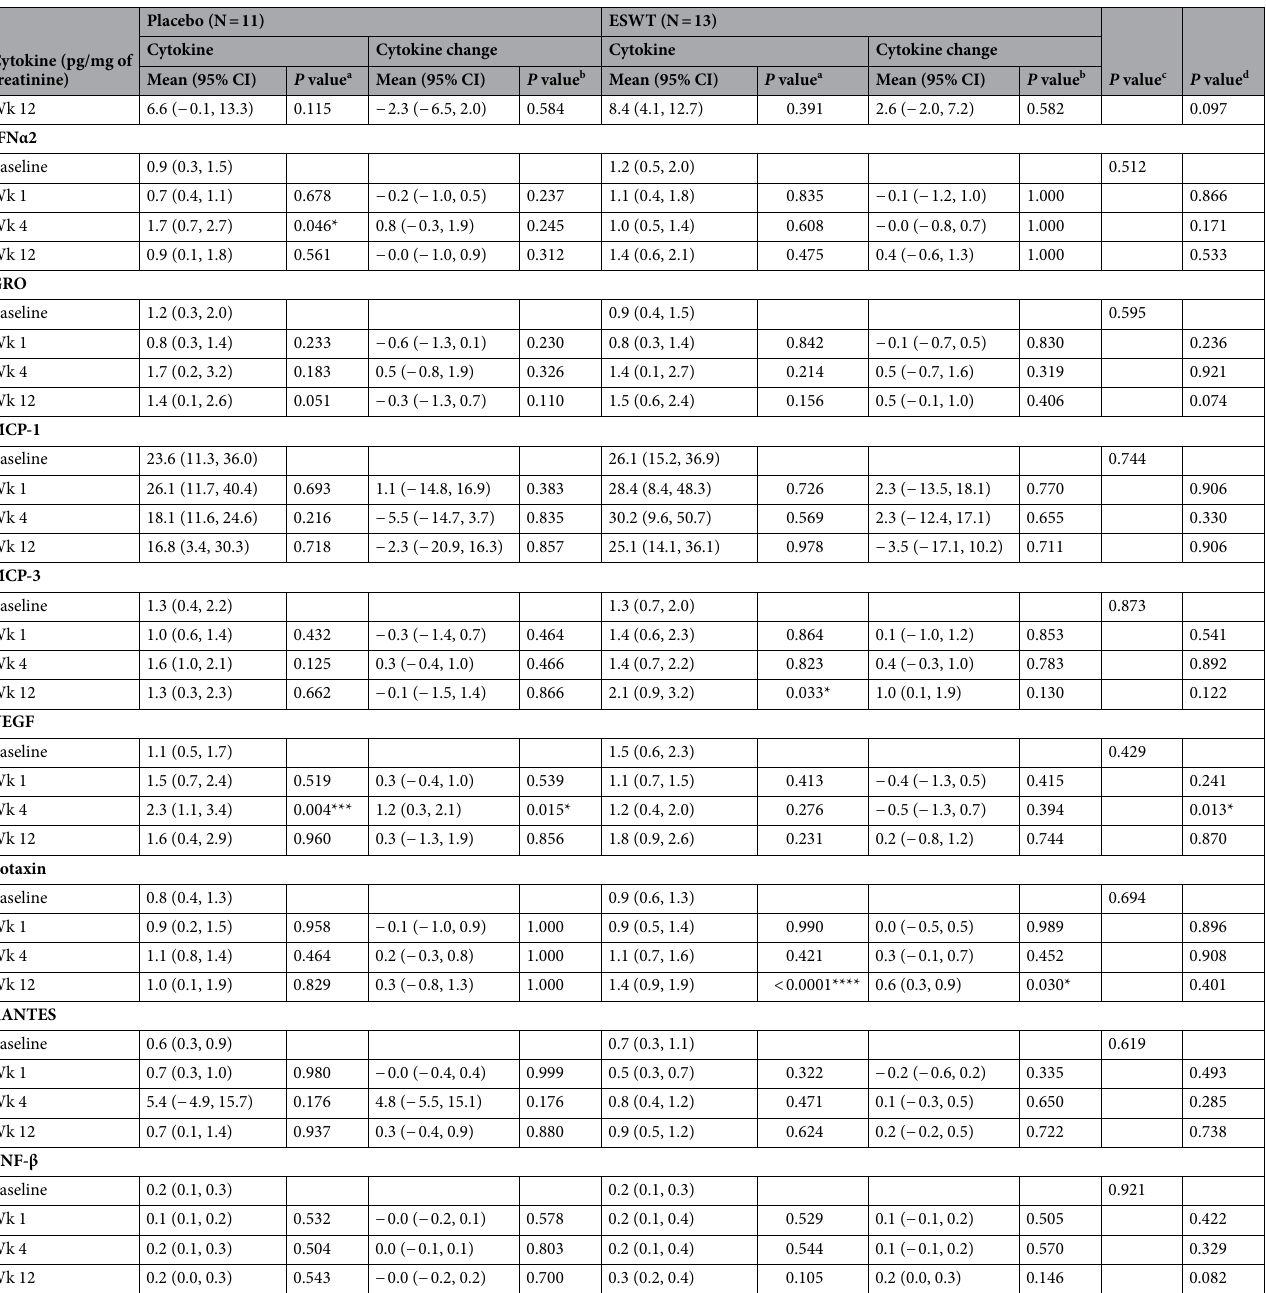
Table 3. Cytokine at baseline, 1, 4, and 12 weeks in patients in ESWT and placebo. Values are presented as mean (95% CI). * P < 0.05, ** P < 0.01, *** P < 0.005, **** P < 0.0001. a Generalized estimating equation compared with baseline. b Cytokine change compared with baseline (generalized estimating equation). c Comparison between baseline of ESWT and placebo (generalized estimating equation). d Comparison between corresponding time point of cytokine change of ESWT and placebo (generalized estimating